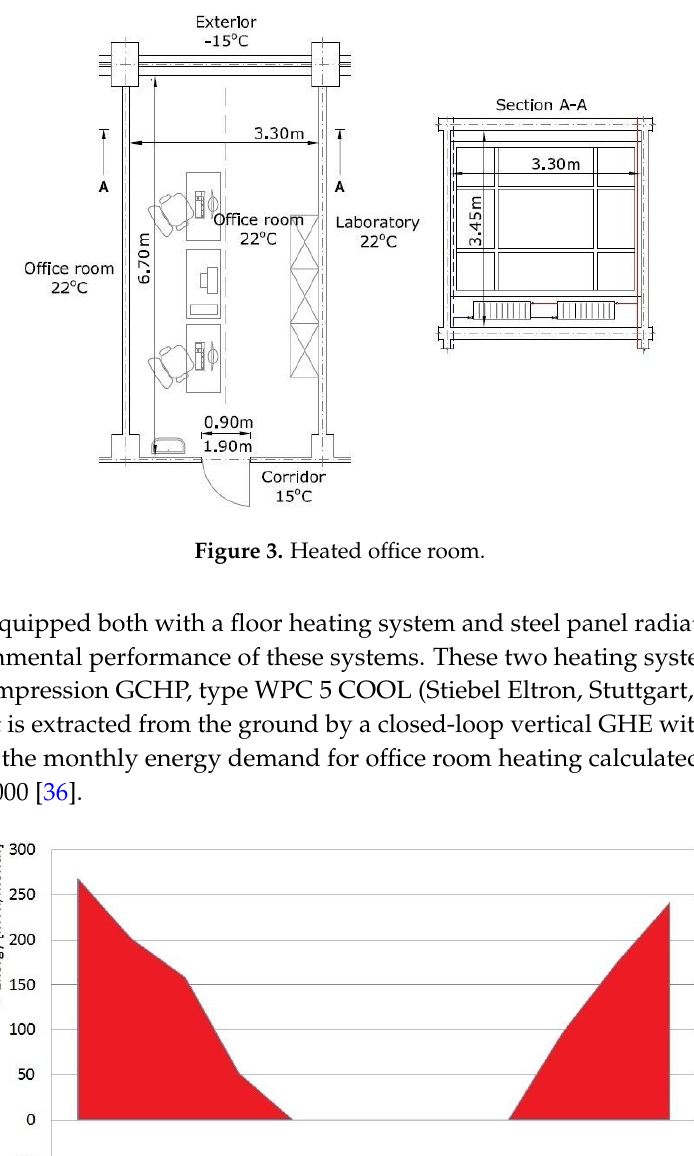
Figure 4. Monthly energy demand for office room heating.